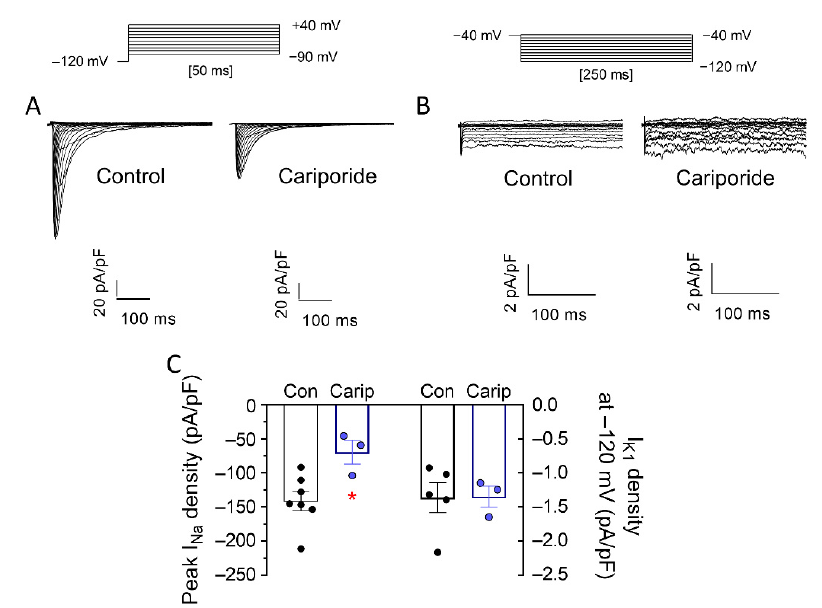
Figure 4. Inhibition of NHE-1 did not mediate increasing effects of dapa and empa on I Na and I K1 . ( A , B ) I Na ( A ) and I K1 ( B ) traces recorded, using the protocol shown at the top, in four different hiPSC-CMs incubated with NHE-1 inhibitor cariporide (10 µM, 24-h) or not incubated (control). ( C ) Maximum densities of peak I Na (left) or I K1 recorded at − 120 mV (right) in cells incubated with cariporide or not incubated. In ( C ), each bar shows the mean ± SEM of the “n” experiments, and each point represents one experiment. * p < 0.05 vs. control.